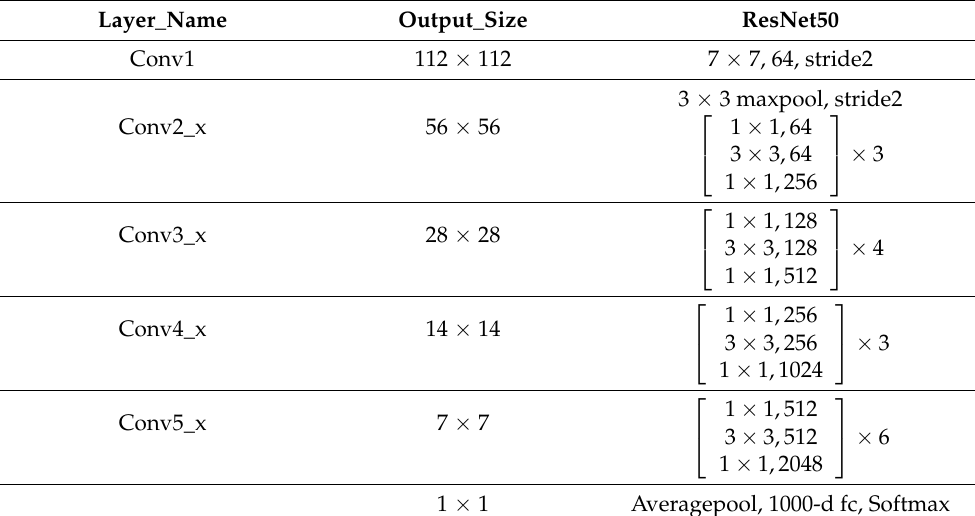
Table 2. ResNet50 structure